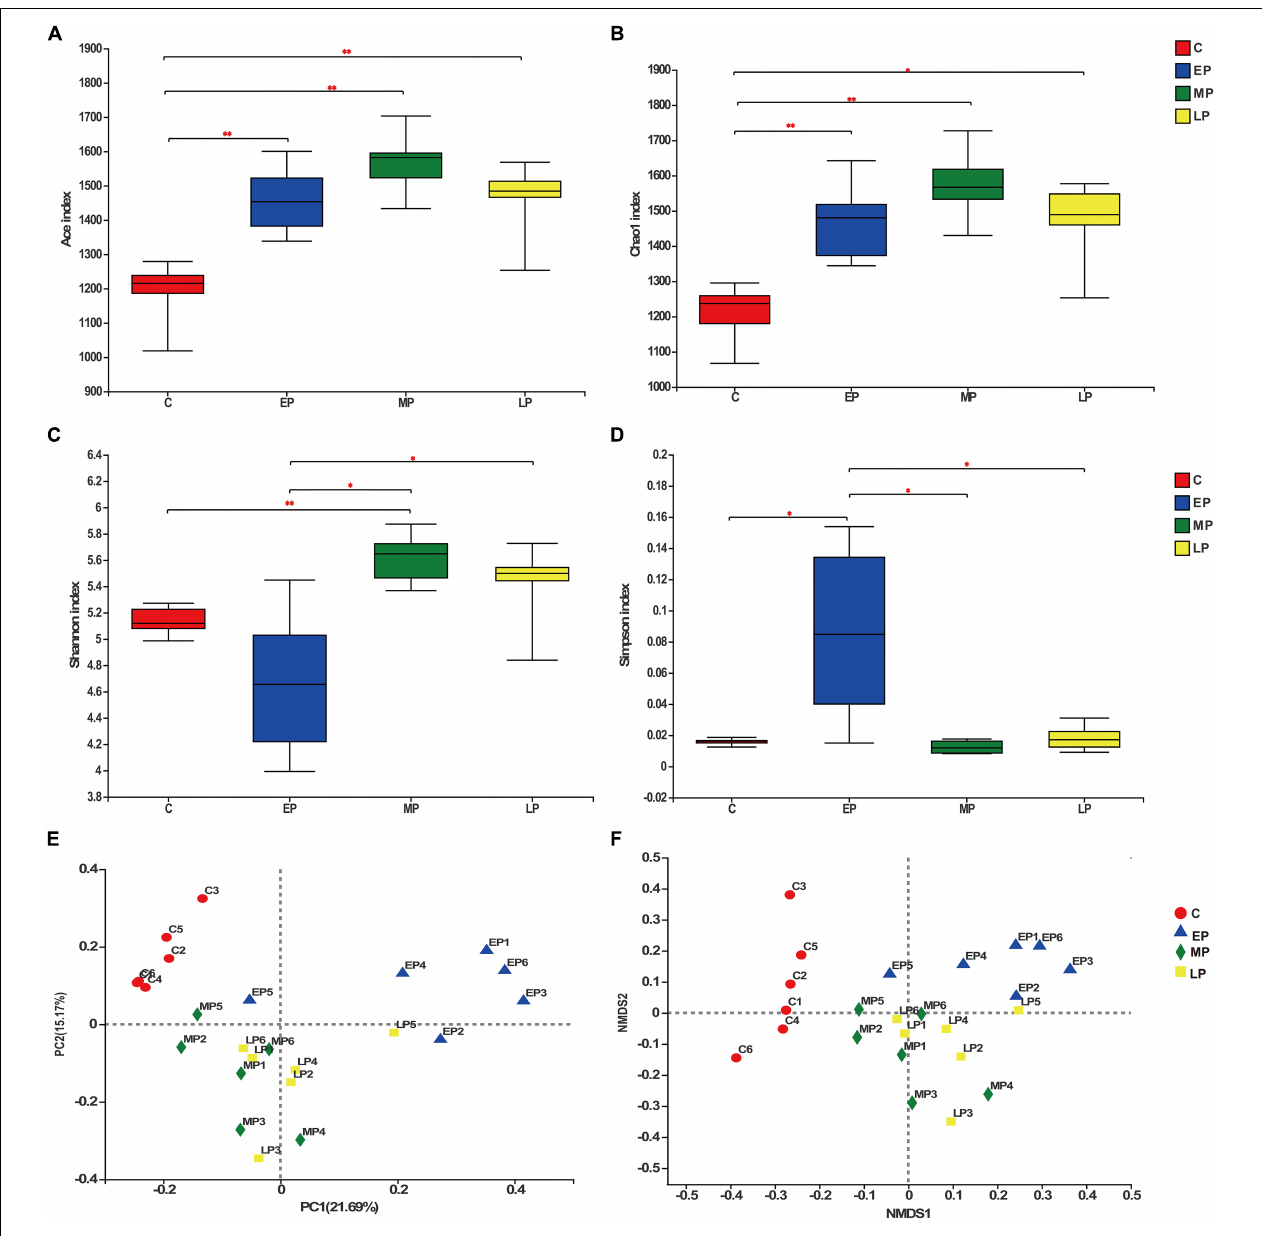
FIGURE 2 | The biodiversity of the gut microbiota is significantly changed during different gestation stages. Richness determined by the Ace (A) and Chao 1 indices (B) and α diversity determined by the Shannon (C) and Simpson indices (D) . Principal coordinate analysis [PCoA; (E) ] and non-metric multidimensional scaling [NMDS; (F) ] analyses based on Bray-Curtis distance showing the differences in the gut microbiota in different gestation stages. C, non-pregnancy as a control; EP, early-stage pregnancy; MP, middle-stage pregnancy; LP, late-stage pregnancy. Data indicate means ± SEM ( n = 6), ∗ p < 0.05, ∗∗ p <